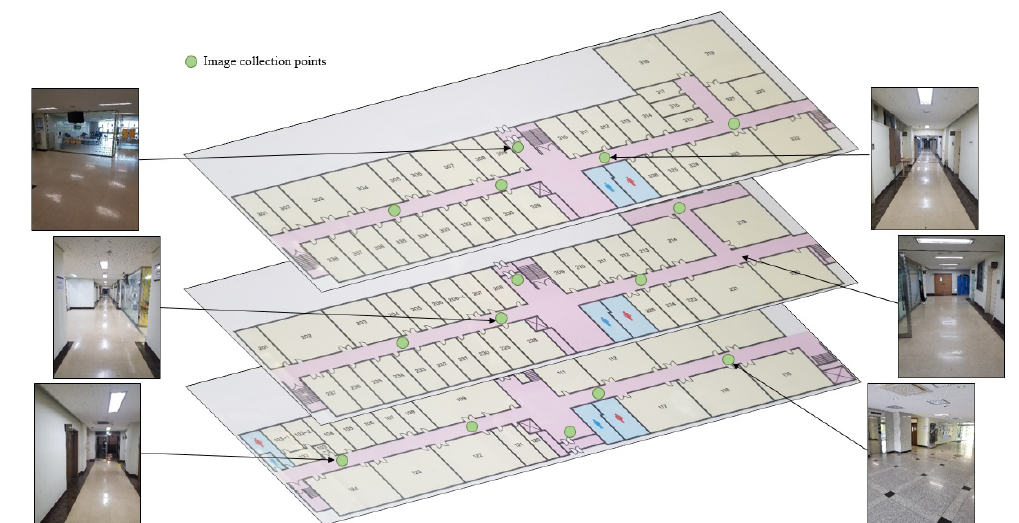
Figure 3. Image capturing points for training.